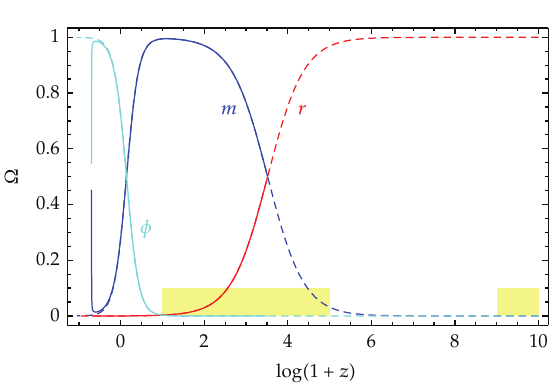
(cid:2) 1 (cid:10) z (cid:3) for the potential V (cid:9) A cos (cid:2) ϕ (cid:3) , ϕ i /π (cid:9) 0.1 (cid:2) solid (cid:3) versus Λ CDM (cid:2) dotted (cid:3) . Figure 1: Ω versus log 10 The light yellow rectangles are the bounds on Ω DE from LSS, CMB, and BBN.